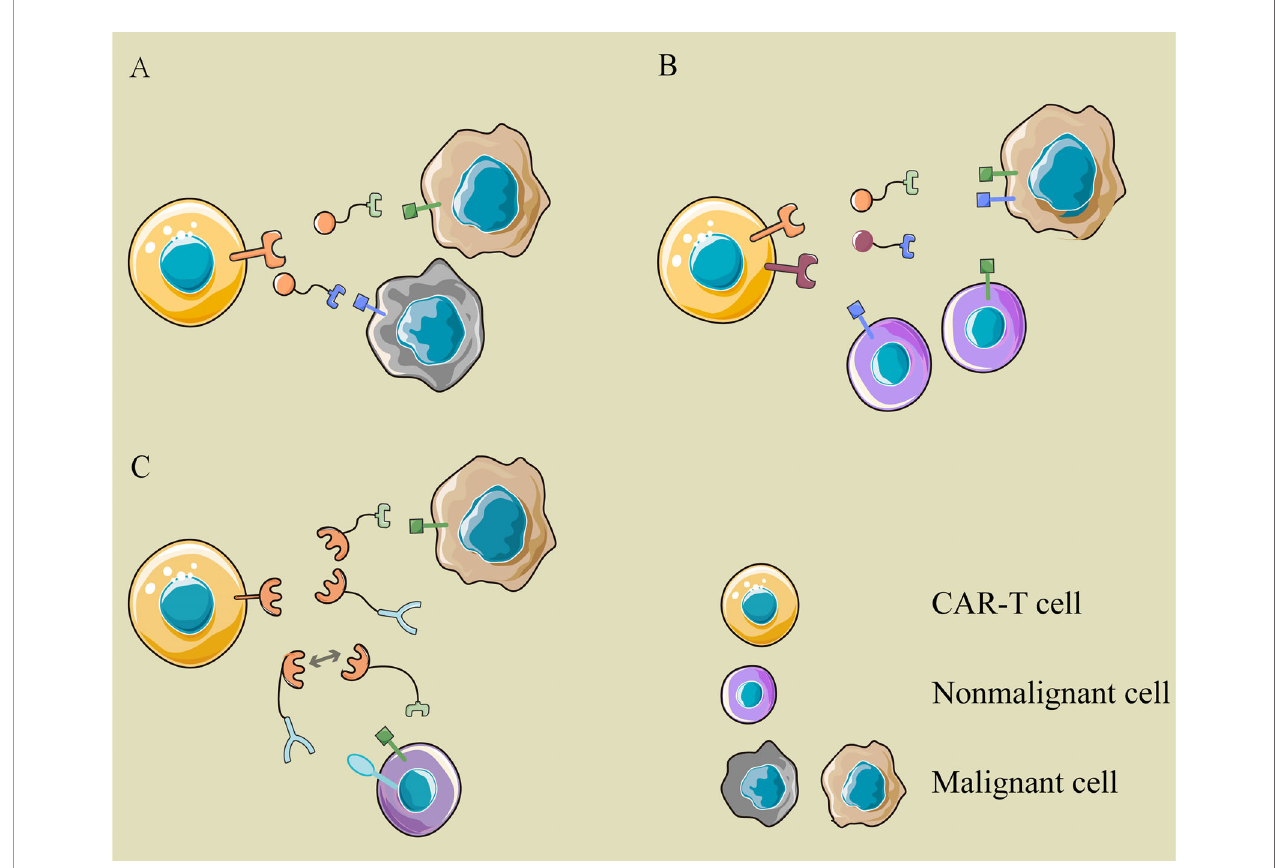
FIGURE 3 | The logic gatings in modular CAR. (A) OR logic: the modular CAR-T cell can eliminate different cancer cells with various switching modules, which are recognized by the same CAR-T cell but target different antigens on cancer cells. (B) AND logic: the antigen-binding domain and costimulator are separated into two CARs targeting different antigens and cotransduced into T cells. Only when tumor cells express two antigens simultaneously can they be recognized and attacked by these CAR-T cells. (C) NOT logic: a tumor-associated antigen is expressed on cancer cells and normal cells simultaneously, while another antigen is expressed on normal cells only. The two modules binding to them are complementary in the site recognized by the signaling module. The extra target works as a safety label to prevent the “ on-target, off-tumor ” toxicity of CAR-T